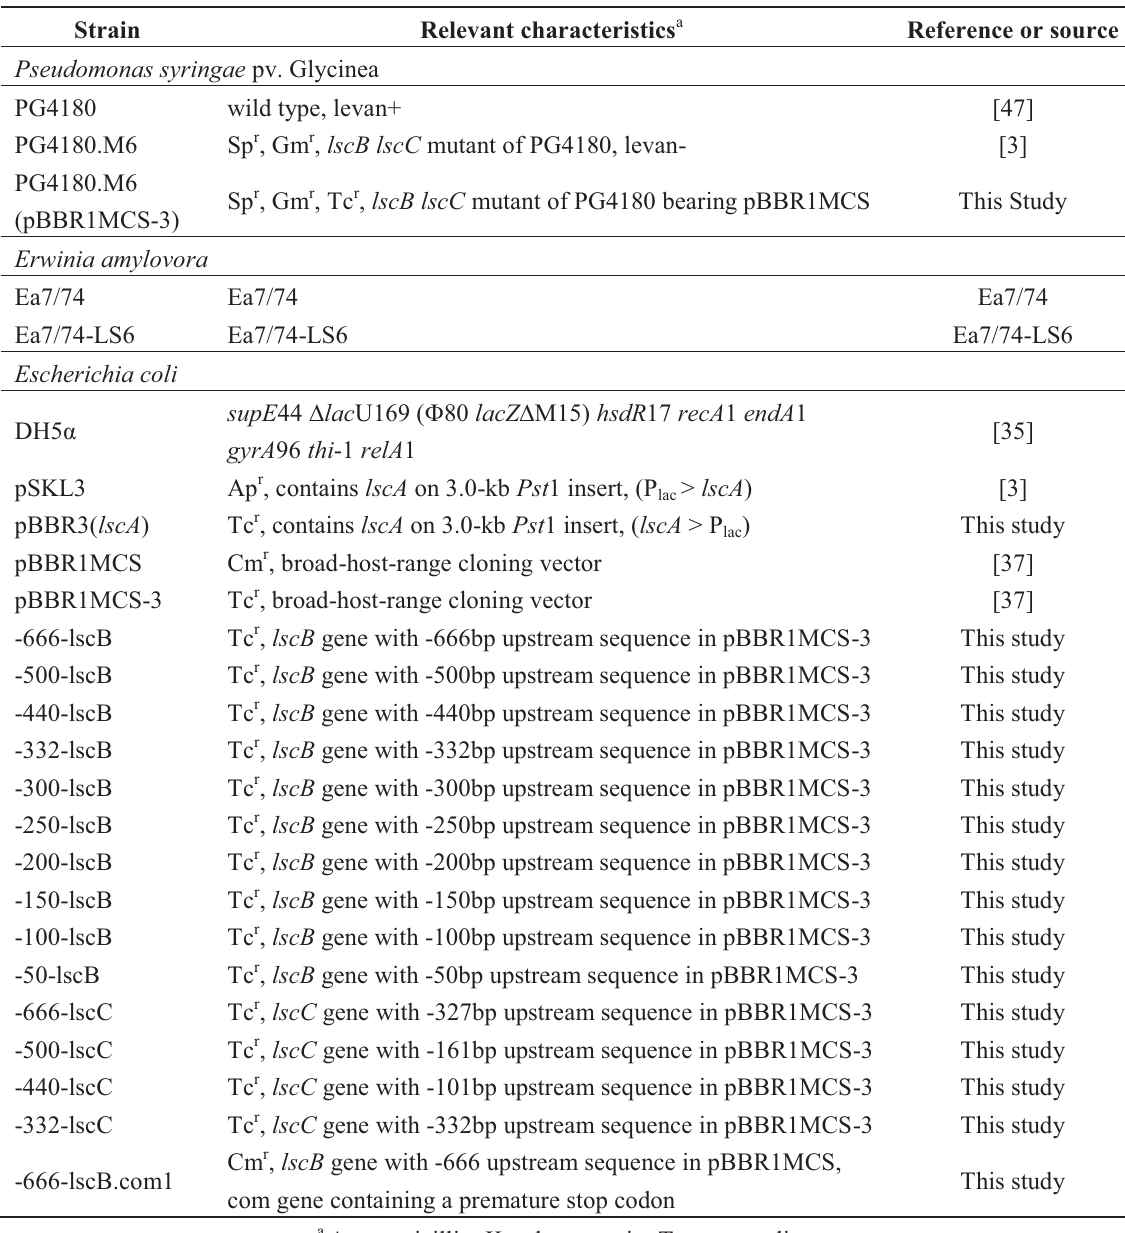
Table 3. Bacterial strains and plasmids used in this